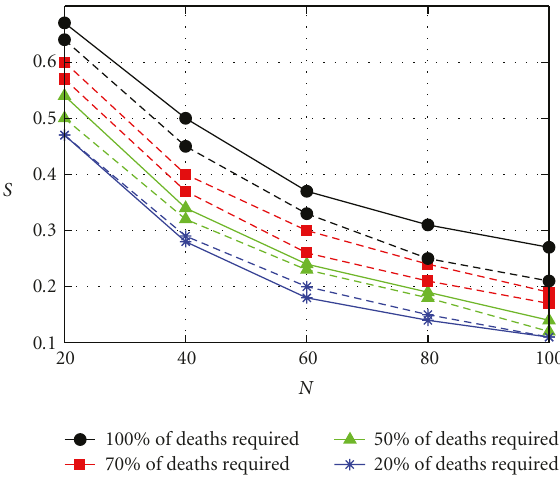
Figure 16: Throughput, as a function of the number of sensors N , in a ZigBee wireless sensor network with nodes’ failures. Two possi- ble distributions for a single sensor lifetime are considered: (a) ex- ponential with μ = 300 seconds (solid lines) and (b) uniform with t max = 600 seconds (dashed